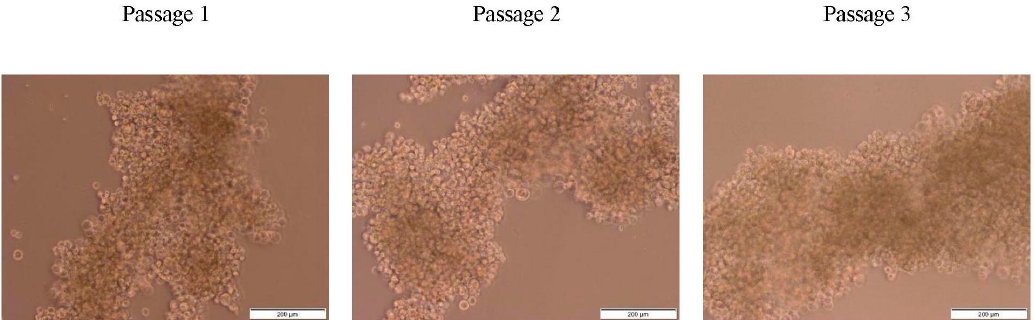
Figure 2. Microphotographs of mammospheres show no obvious changes in morphology at passage 1 to 2 cultured in ultra-low attachment plates.